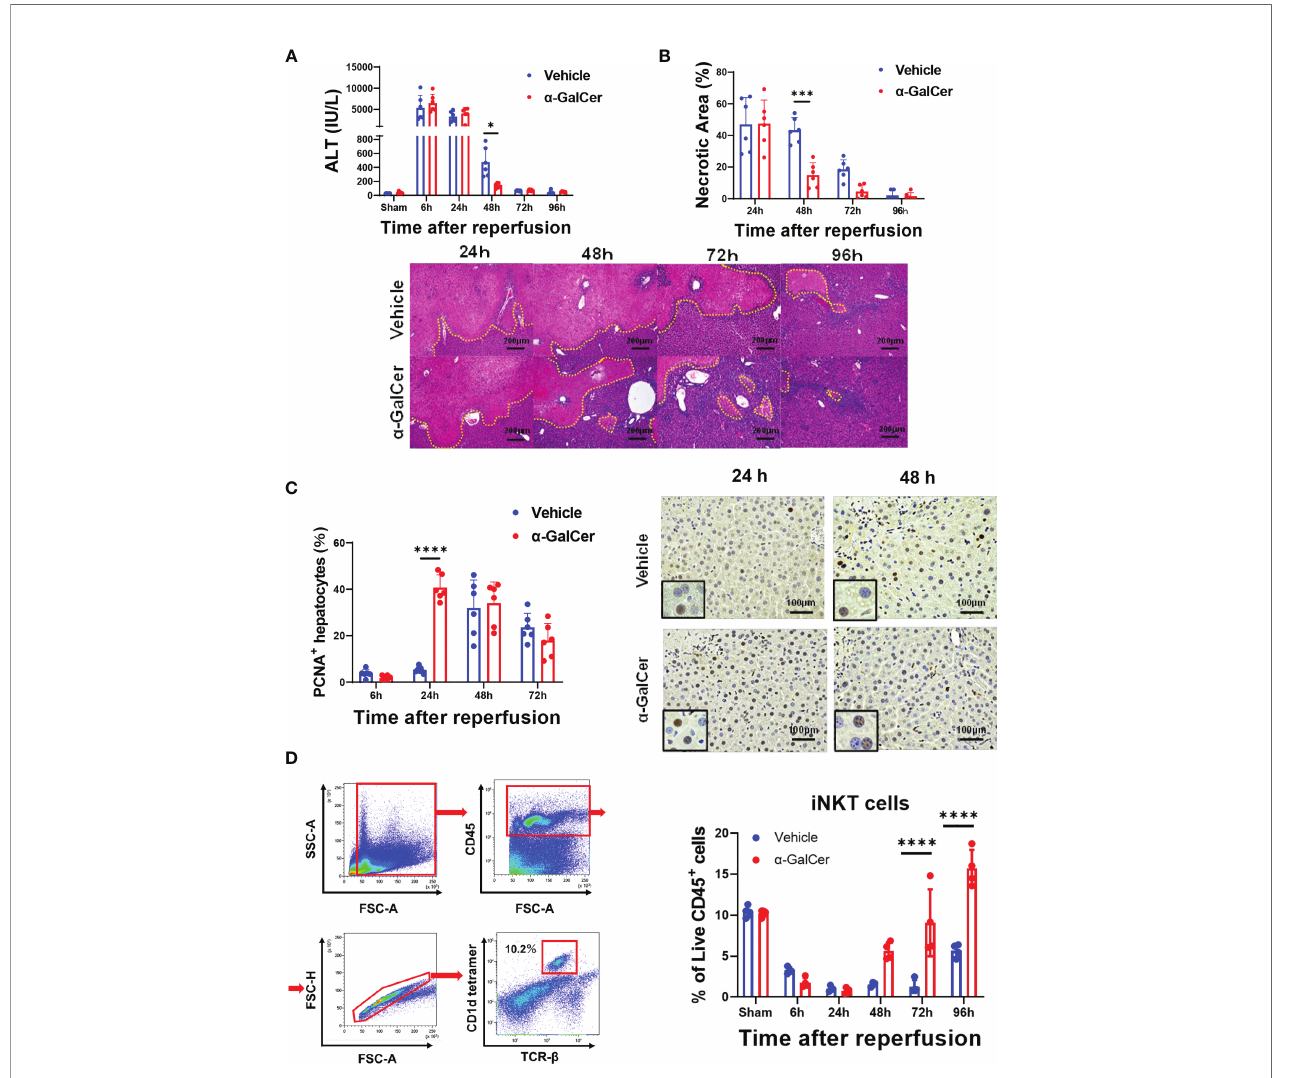
FIGURE 1 | Activation of iNKT cells facilitates liver repair after hepatic I/R injury. (A, B) Changes in ALT levels (A) and hepatic necrotic area (B) in mice treated with a -GalCer and vehicle after hepatic I/R injury. Data are expressed as the mean ± SD (six biological replicates per group). * P < 0.05, *** P < 0.001. Representative photomicrographs of H&E-stained liver sections from mice treated with a -GalCer or vehicle after hepatic I/R injury. Scale bars, 200 m m. (C) Changes in PCNA + - hepatocytes in mice treated with a -GalCer or vehicle. Data are expressed as the mean ± SD (six biological replicates per group). **** P < 0.0001. Representative images showing immunohistochemical staining of PCNA in mice treated with a -GalCer or vehicle at 24 h and 48 h post-reperfusion. Large and round cells are considered hepatocytes, and typical labeled hepatocytes are shown at the lower left corner. Scale bar, 100 m m. (D) Representative dot plots and the gating strategy for iNKT cells in sham-operated mice. Changes in hepatic iNKT cells in mice treated with a -GalCer or vehicle after hepatic I/R injury. Data are expressed as the mean ± SD (four biological replicates per group). **** P <